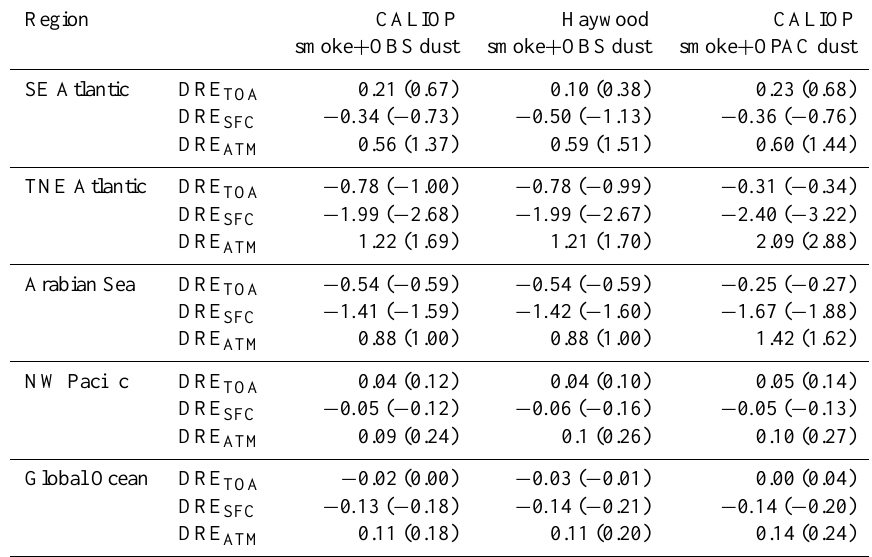
Table 4. The regional and annual mean of diurnally averaged cloudy-sky DREs at TOA based on different combinations of aerosol optical models. The numbers in the parentheses are results based on the scaled AOT (see Sect. 6 for details). The unit is Wm − 2 .